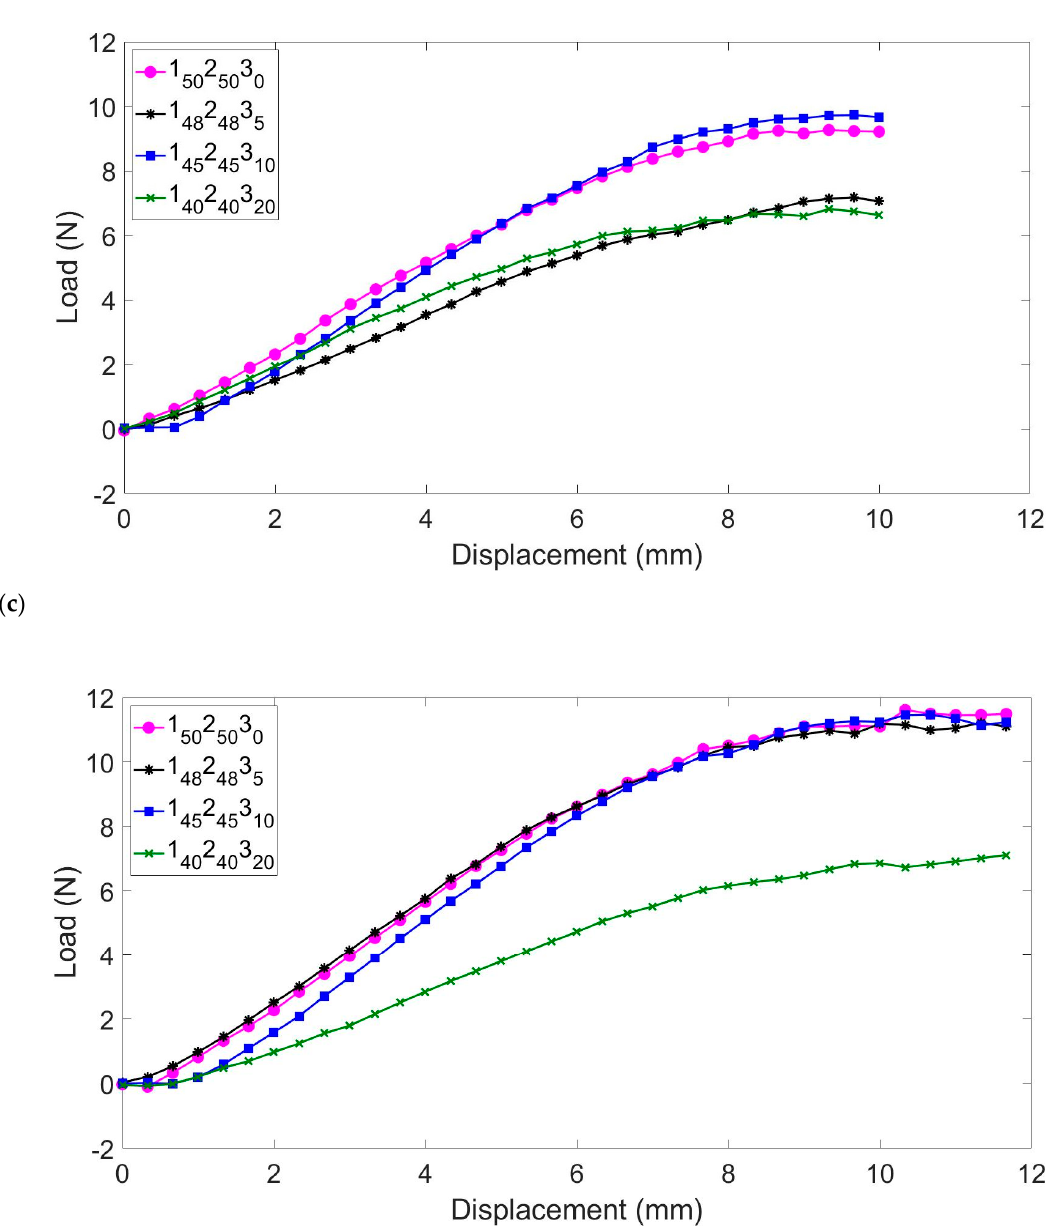
Figure 7. Three-point bending test applied to cured samples after the equivalent of ( a ) 4, ( b ) 8, and ( c ) 12 months in a simulated LEO environment.